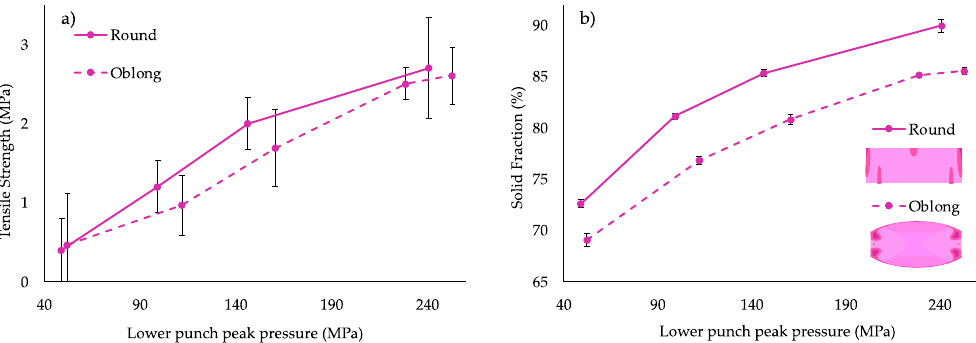
Figure 11. ( a ) Tabletability plot for round/oblong ITZASD tablets with the TS ( σ t ) and ( b ) compress- ibility plot and cross-sections of high- and low-density distribution for round/oblong ITZASD tablets, respectively ( n =